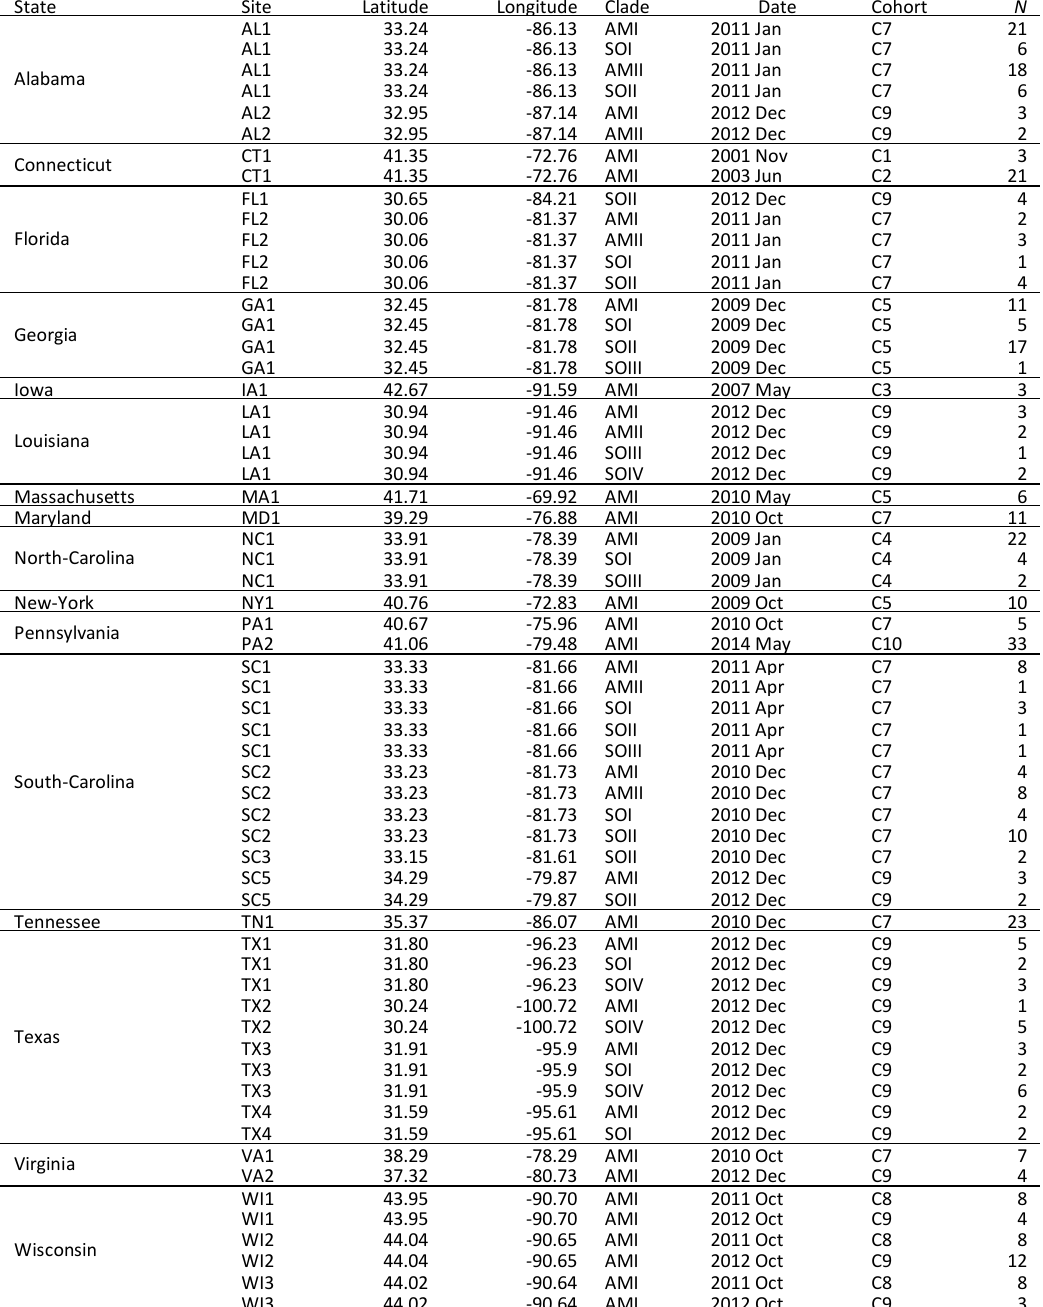
Table 1. State, site, GPS coordinates (decimal degrees), 12S clade membership, date of sampling, corresponding cohort membership and size of Ixodes scapularis adult subsamples ( N ) from the